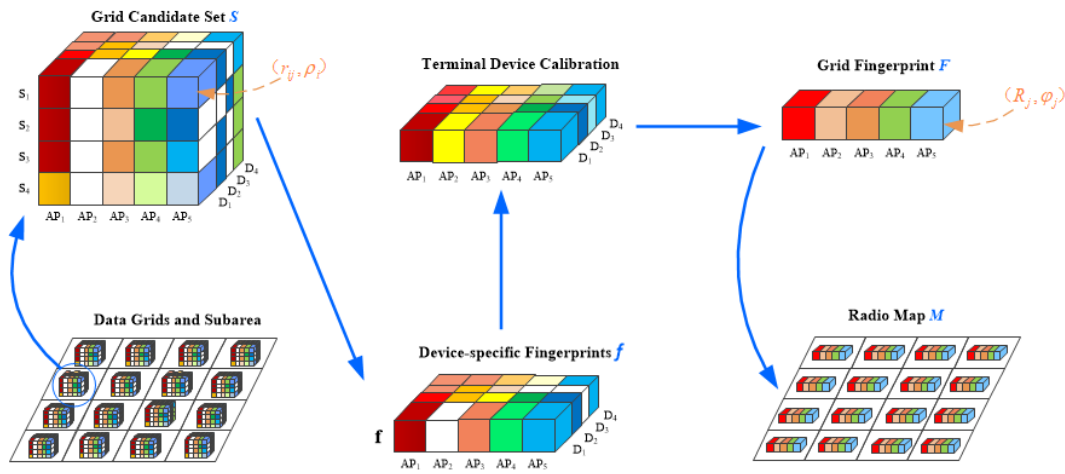
Figure 2. Process flow of the proposed